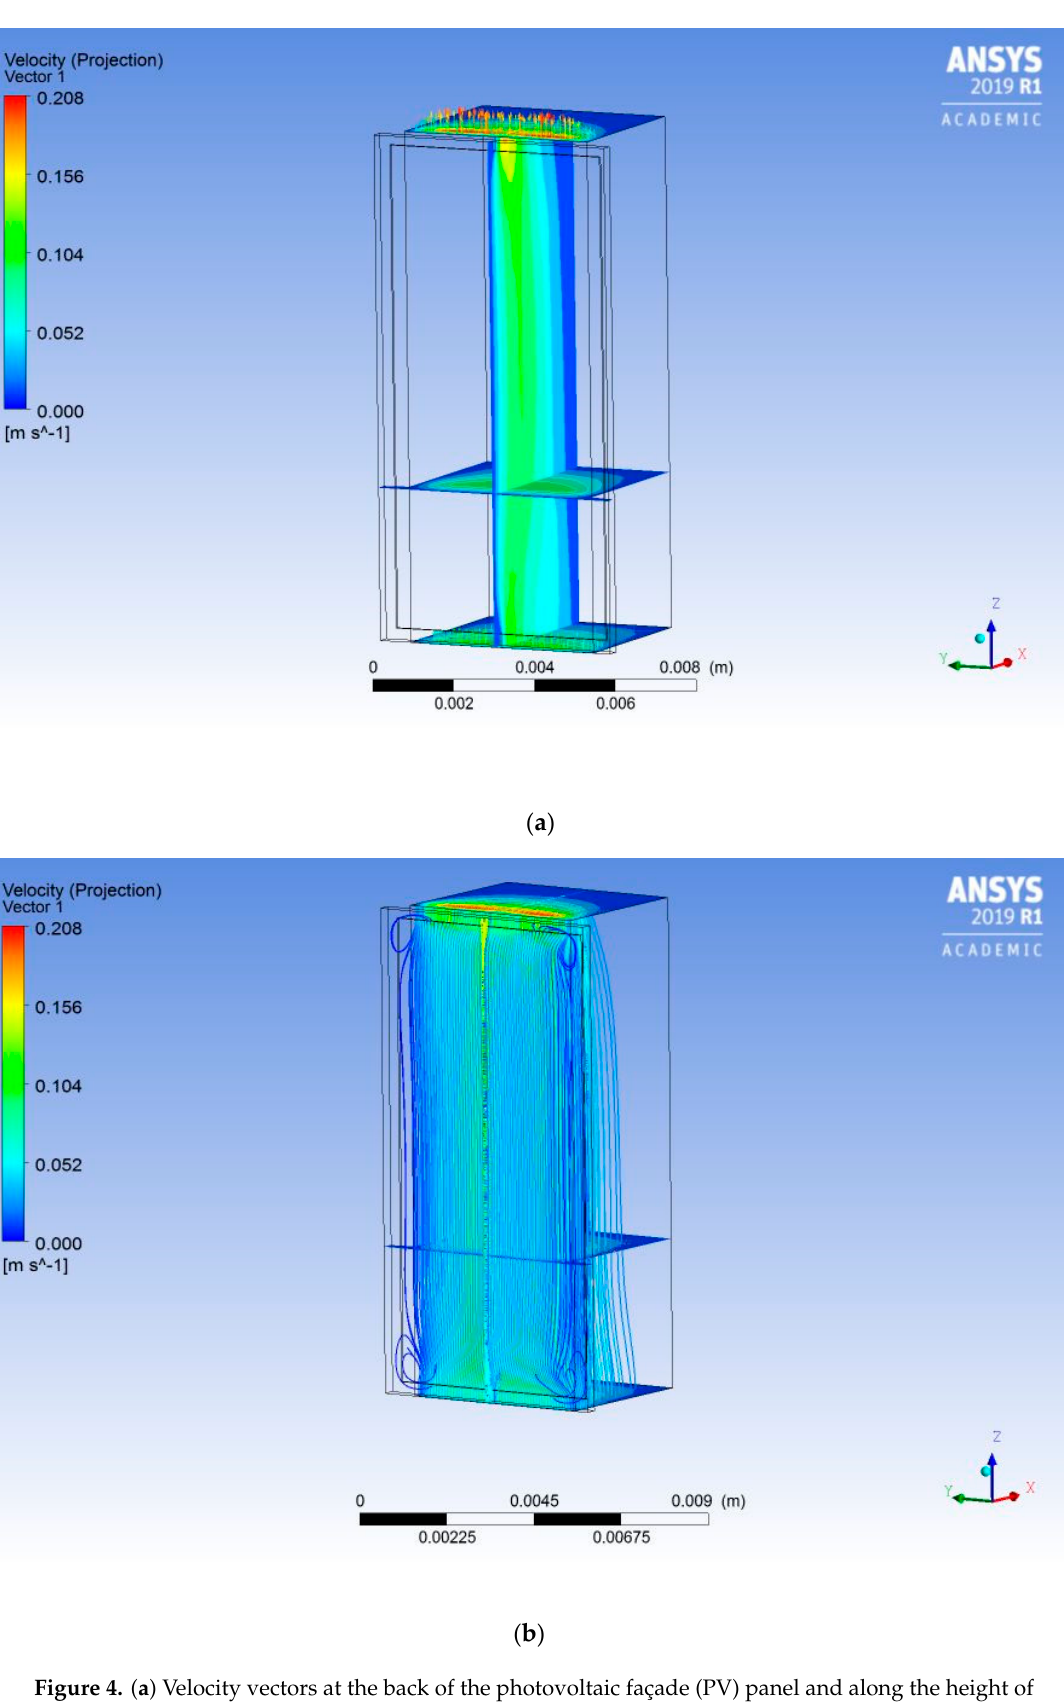
Figure 4. ( a ) Velocity vectors at the back of the photovoltaic façade (PV) panel and along the height of Duct-2 with a 45 cm width; ( b ) velocity streamline entering from the inlet to outlet on the top of the duct and streamlining at the back of the PV.